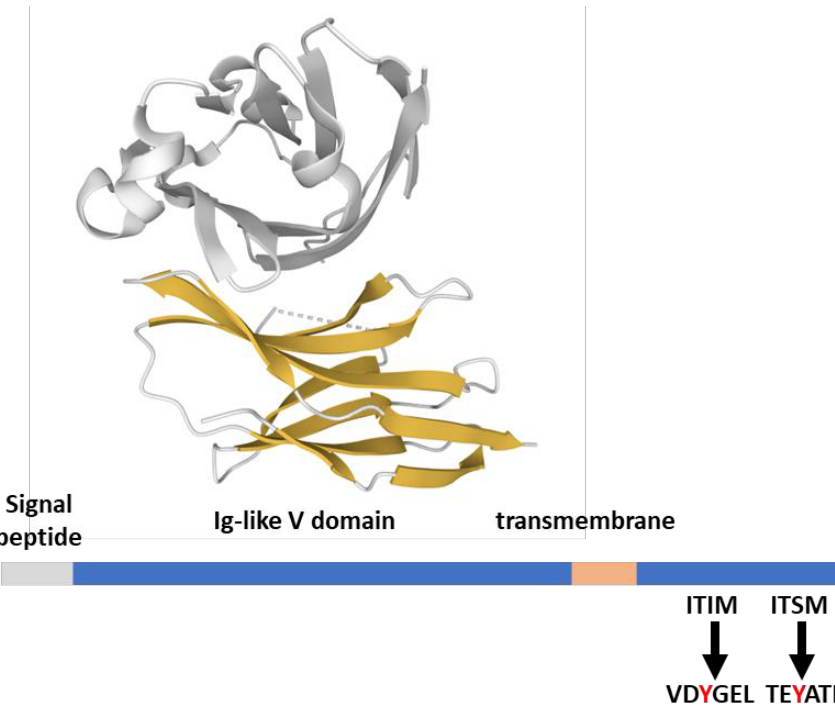
Figure 2. PD-1 structural features. PD-1 (288 aa) features from the Uniprot database; the extracellular domain in complex with its ligand PD-L1 (gray) is 4ZQK [37], rendered by the Mol* application [10].